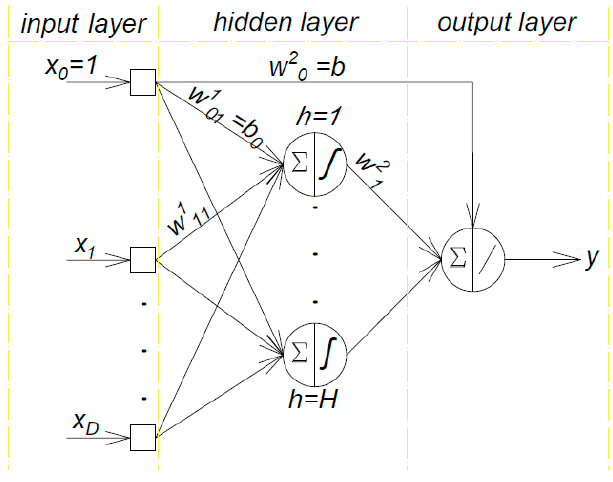
Figure 2. The architecture of the FLNN with one hidden layer.